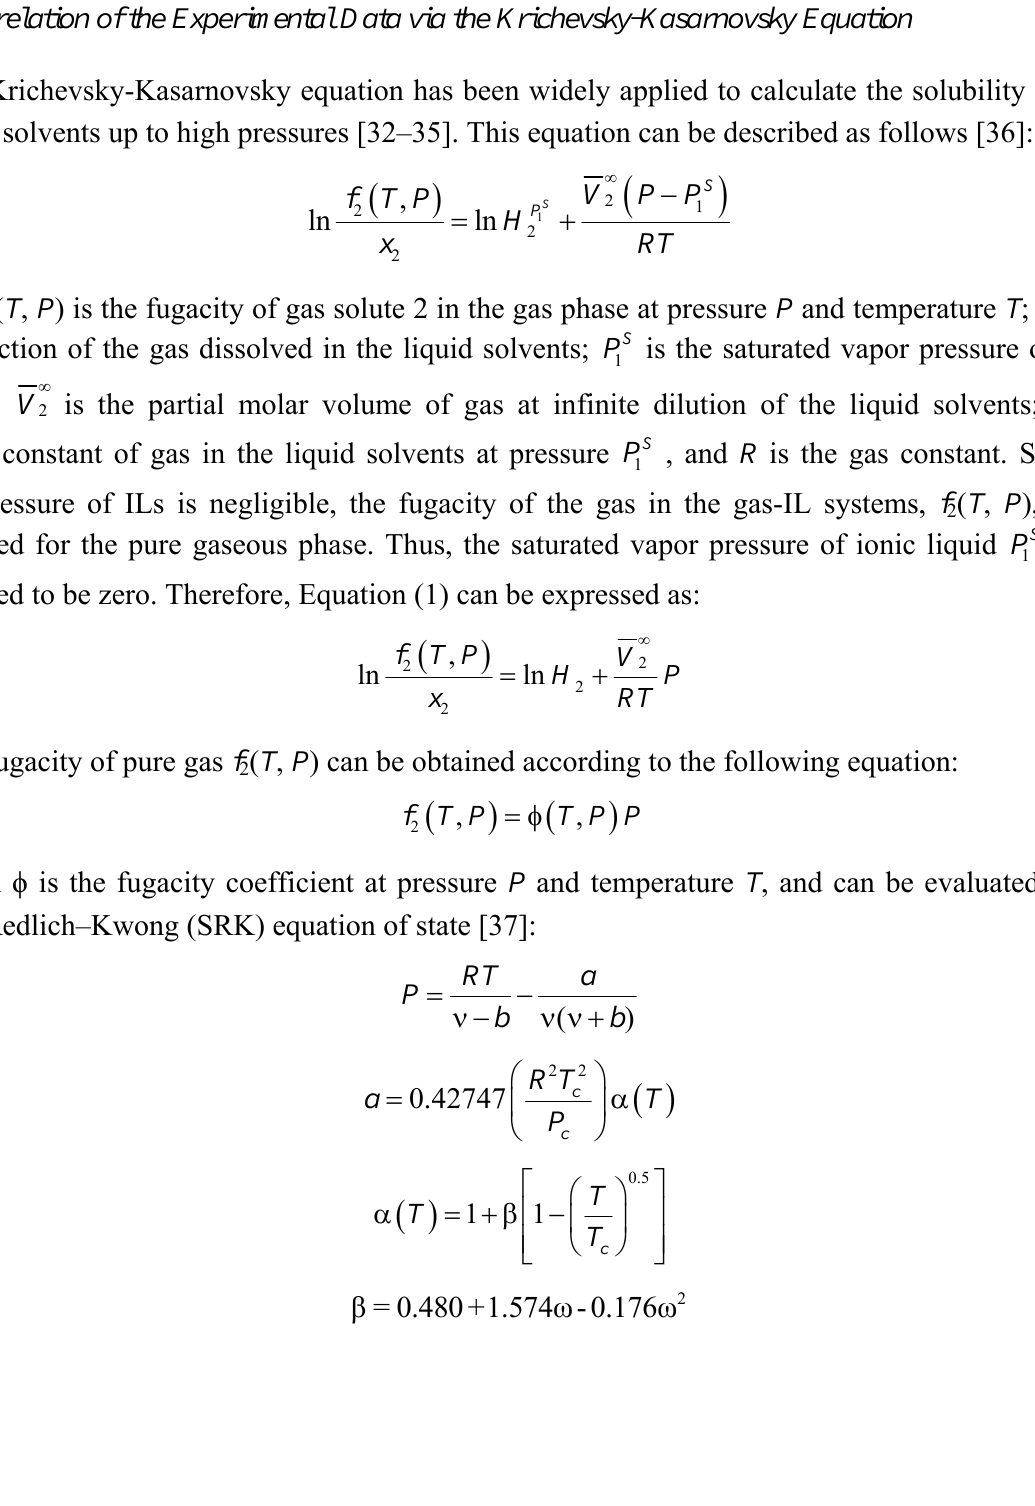
Table 2. Experimental solubility values, expressed as the mole fraction x